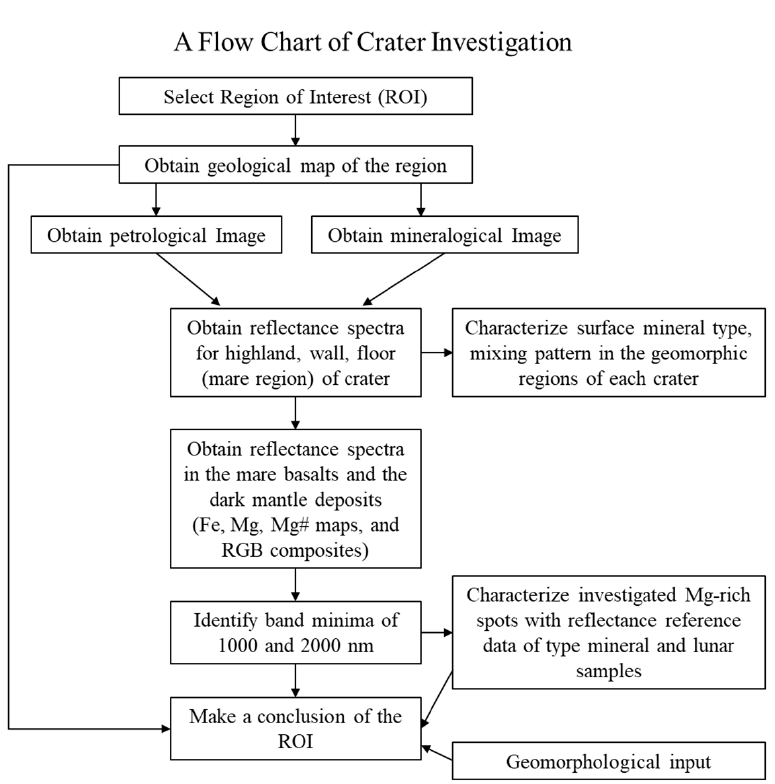
Figure A1. A flow chart of crater investigation described in this study.